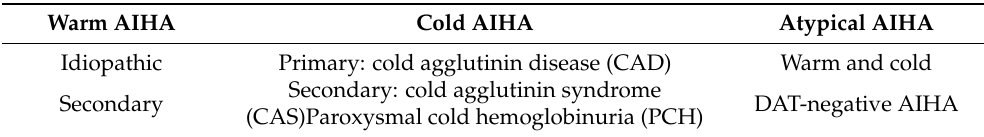
Table 1. Classification of autoimmune hemolytic anemias (AIHA). Warm AIHA Cold AIHA Atypical AIHA Idiopathic Primary: cold agglutinin disease (CAD) Warm and cold Secondary: cold agglutinin syndrome (CAS) DAT ‐ negative AIHA Secondary Paroxysmal cold hemoglobinuria (PCH)